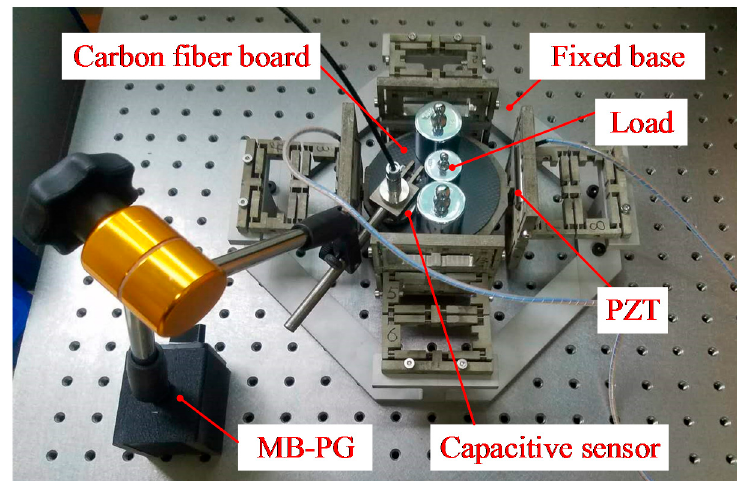
Figure 17. Experimental setup for load capacity tests.